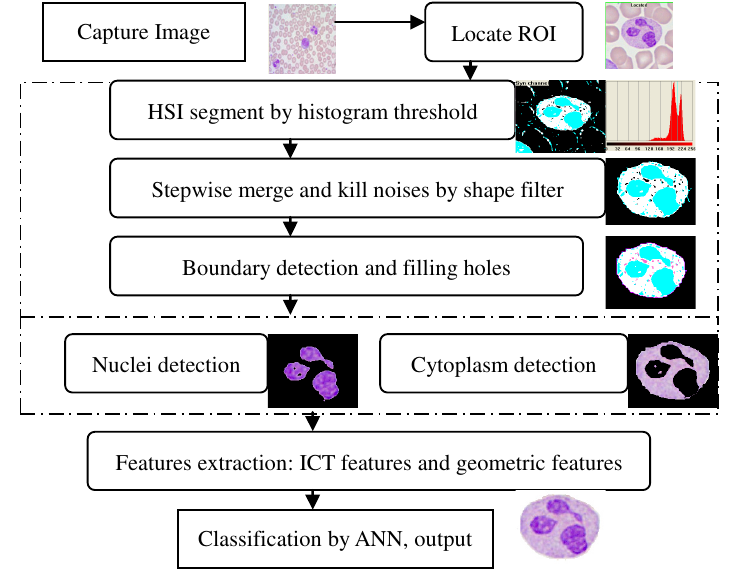
Fig. 14. Software °ow chart and architecture.